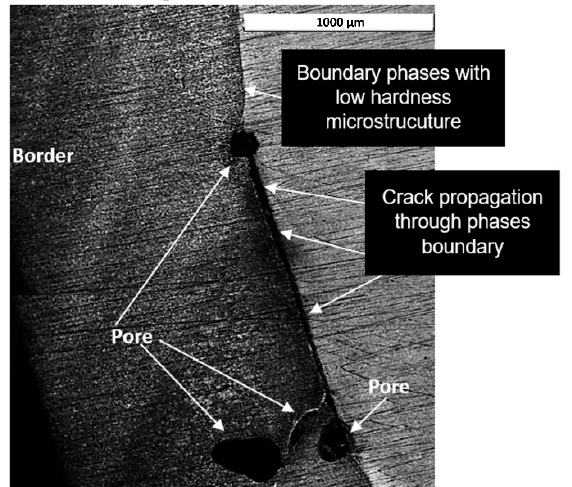
Figure 13. Crack propagation between two pores along the boundary line of low hardness